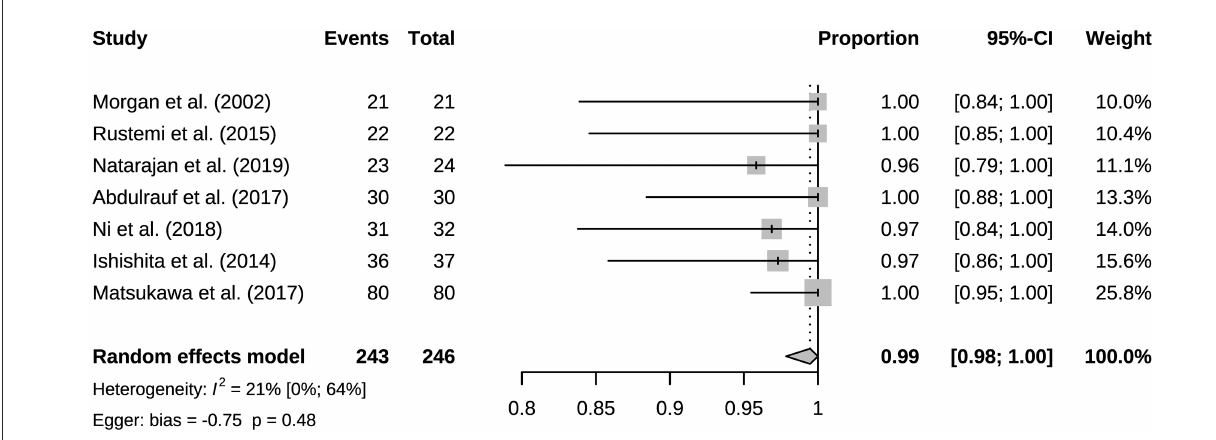
FIGURE2 Immediate postoperative bypass patency of included